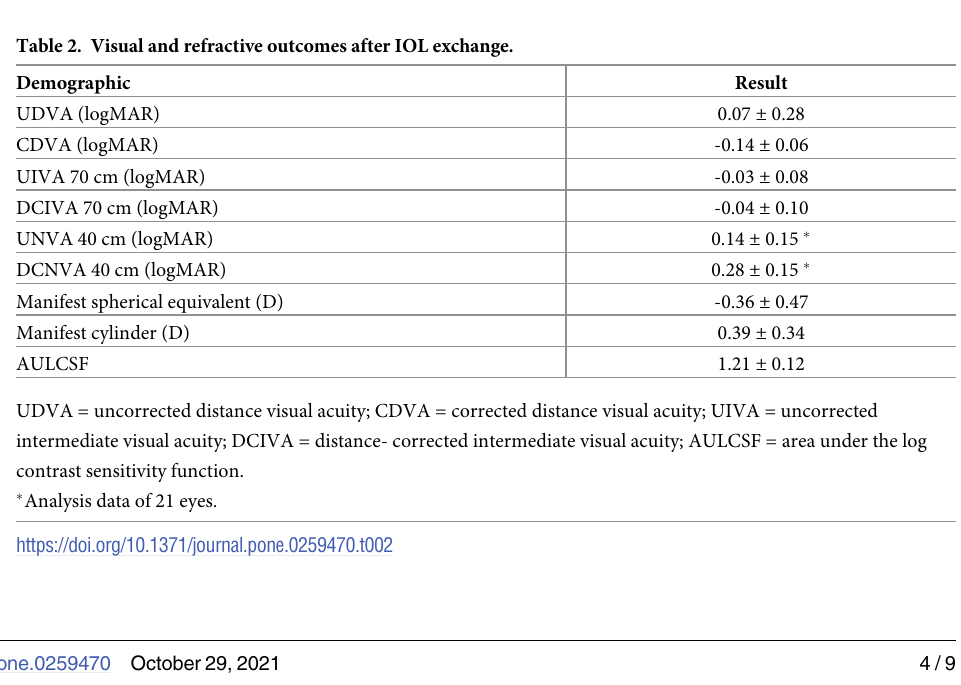
Table 2. Visual and refractive outcomes after IOL exchange.